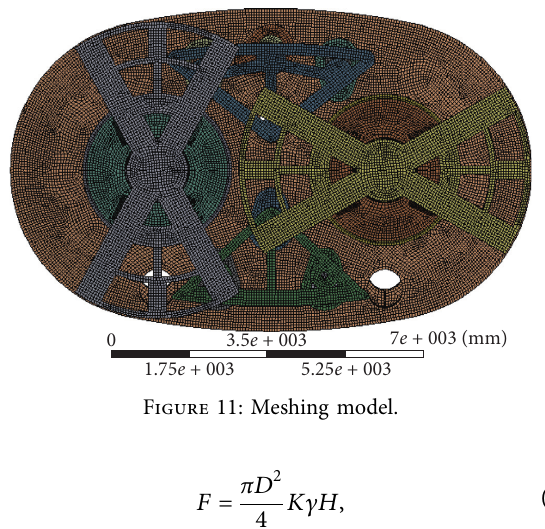
Figure 11: Meshing